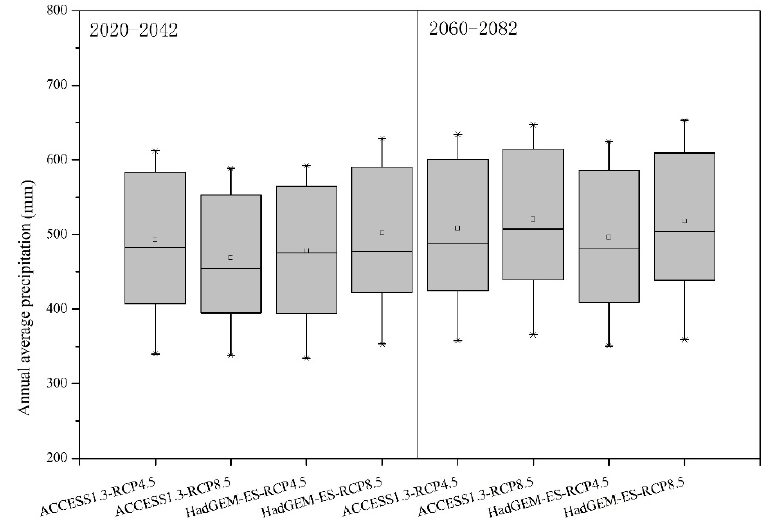
Figure 7. Projected mean of precipitation under the different combinations of GCMs and RCPs scenarios during the different assessment periods.